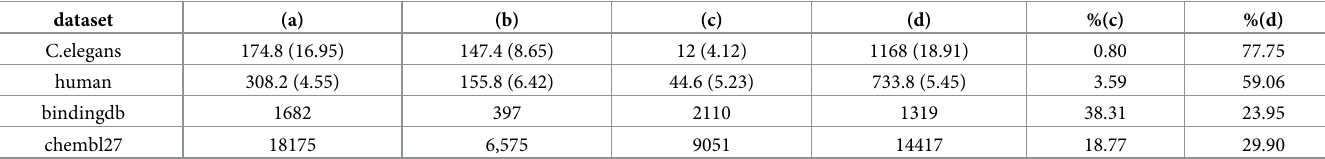
Table 3. A summary of CPIs in the testing data of two datasets bindingdb and chembl27 in four scenarios: (a) new compound-known protein, (b) known compound- new protein, (c) new compound-new protein, and (d) known compound-known protein. The two last columns indicate percentage of (c) and (d) in testing data. dataset